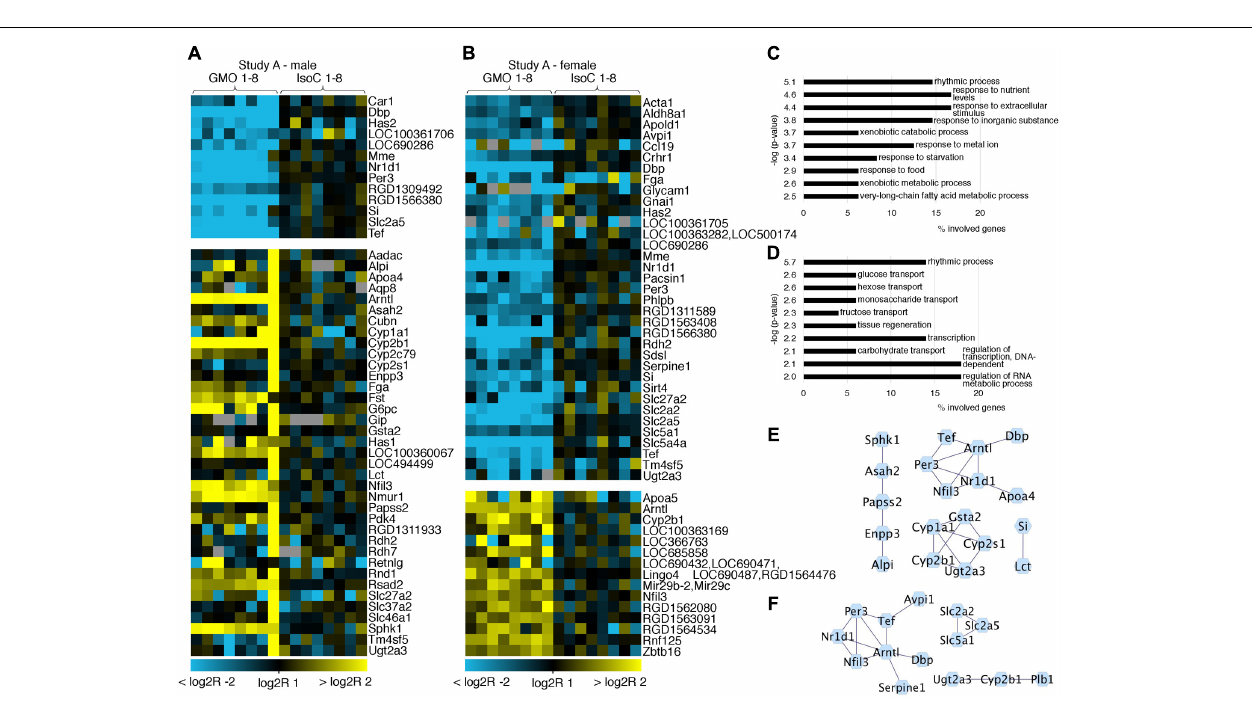
FIGURE 1 | Summary of targeted pathway analysis by RT-qPCR arrays including 79 specific transcripts. A volcano plot analysis of gene expression differences between the 33% GM maize and 33% near-isogenic control maize group is plotted on the x -axis (log2 scale), and the statistical significance ( p < 0.05) is plotted on the y -axis (–log10 scale) both in ileum (A) and colon (B) . The dotted lines indicate fold-changes higher or lower than a twofold up- or down-regulation (values right and left of the vertical lines, respectively) as well as statistical significance (values above the horizontal line).